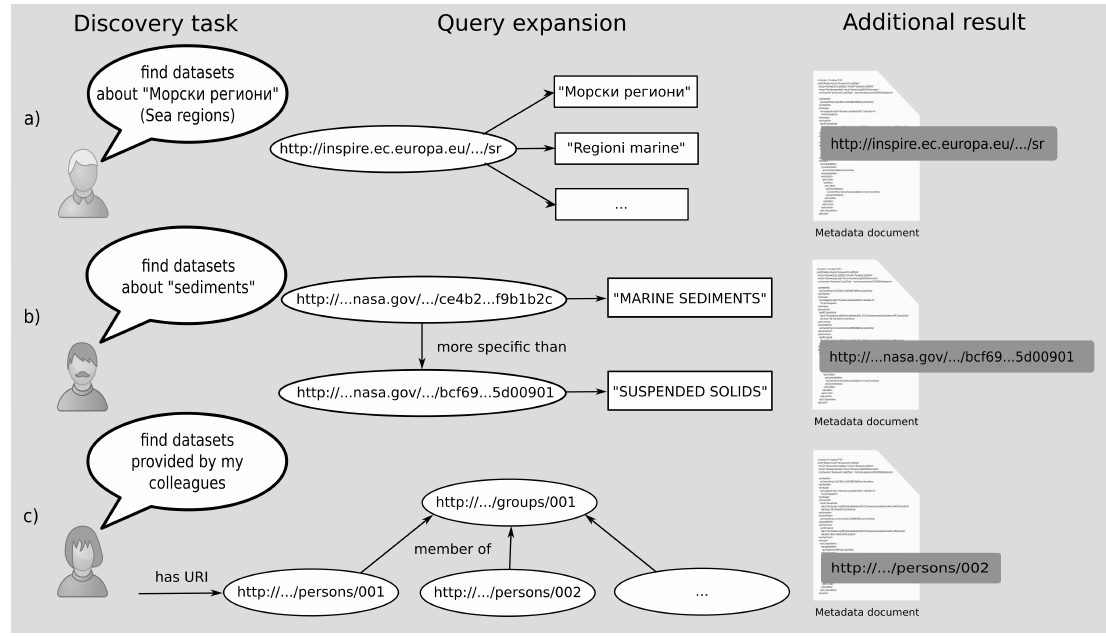
Figure 2. Use cases exemplifying semantic discovery